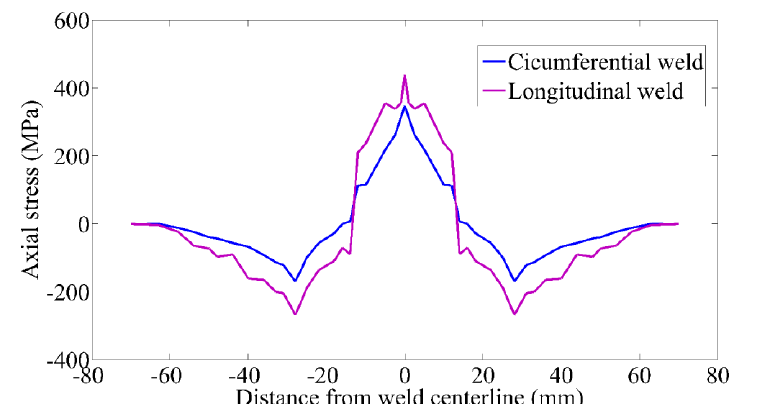
Fig. 14. Residual axial stress distribution on the inner surface for circumferential and longitudinal weld butt joints.